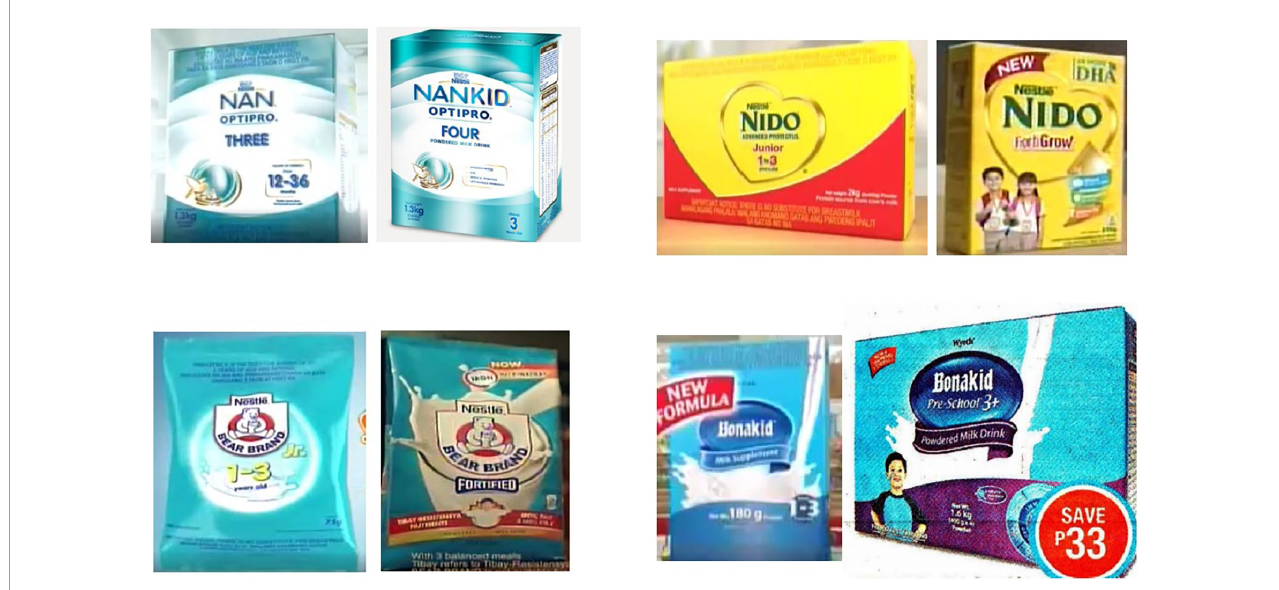
FIGURE3 Images of eight products from the reviewed materials showing cross-promotion through similar packaging, branding, and labeling of CMF for children less than 36 months old (left) and CMF for children 36 months or older (right) .